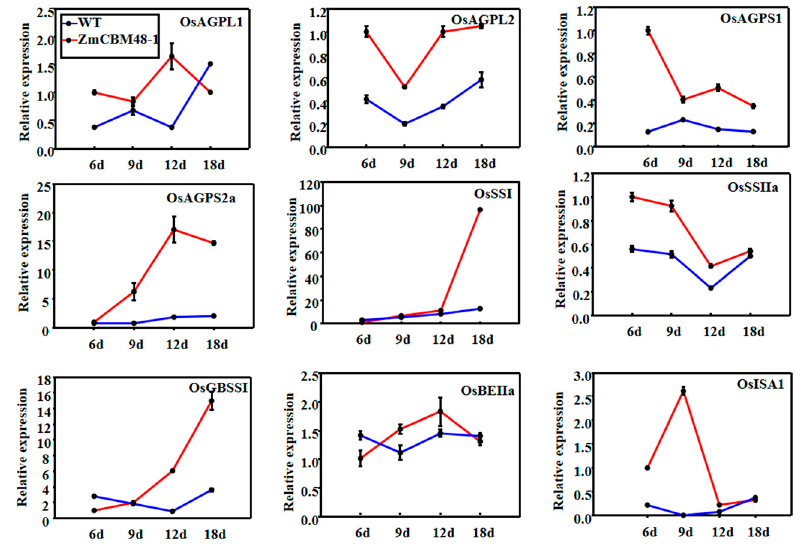
Figure 8. Expression patterns of 16 starch synthesis-related genes at 6, 9, 12, and 18 days after pollination (DAP). The mRNA expression levels of each gene in the six DAP seeds of the wild type (WT) were used as a control.